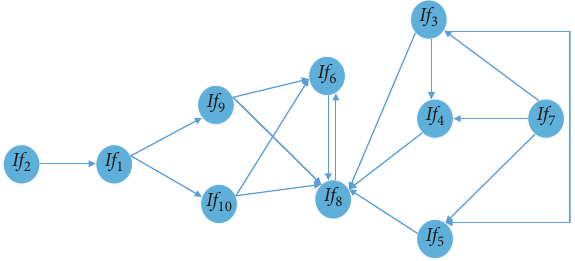
Figure 1: Relationship between influencing